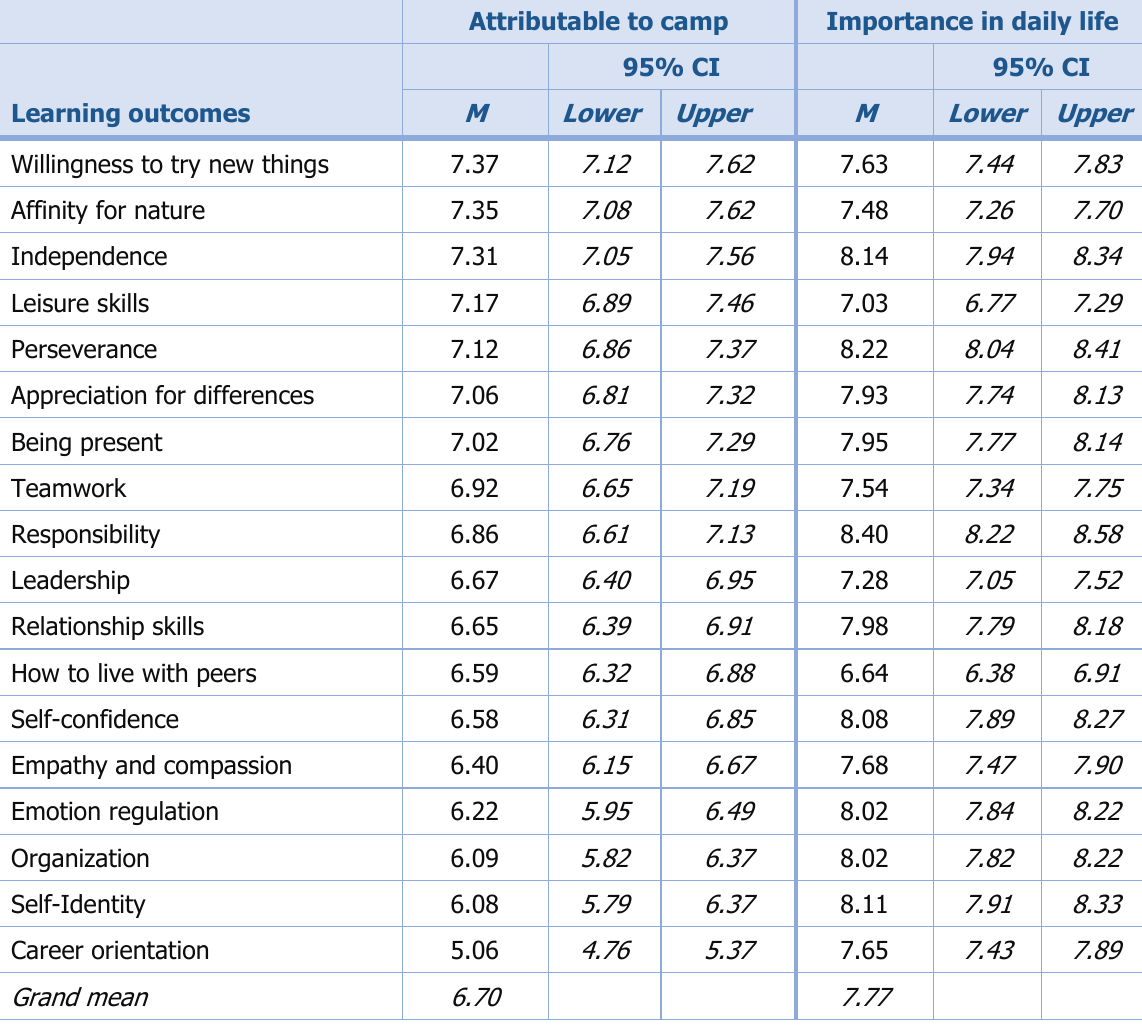
Table 3. Means and Confidence Intervals of Learning Outcomes Attributable to camp Importance in daily